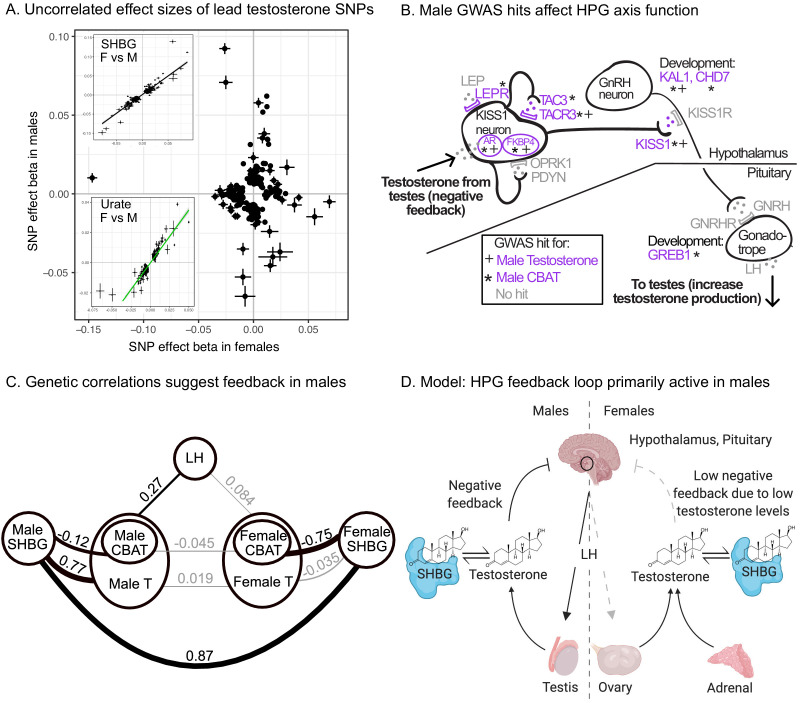
Sex differences in genetic variation in testosterone.(A) When comparing lead SNPs (p<5e-8 ascertained in either females or males), the effects are nearly non-overlapping between females and males. Other traits show high correlations for the same analysis (see urate and SHBG in inset). (B) Schematic of HPG axis signaling within the hypothalamus and pituitary, with male GWAS hits highlighted. These variants are not significant in females. (C) Global genetic correlations, between indicated traits (estimated by LD Score regression). Thickness of line indicates strength of correlation, and significant (p<0.05) correlations are in bold. Note that LH genetic correlations are not sex-stratified due to small sample size in the UKBB primary care data (N = 10,255 individuals). (D) Proposed model in which the HPG axis and SHBG-mediated regulation of testosterone feedback loop is primarily active in males. Abbreviations for all panels: SHBG, sex hormone-binding globulin; CBAT, calculated bioavailable testosterone; LH, luteinizing hormone.